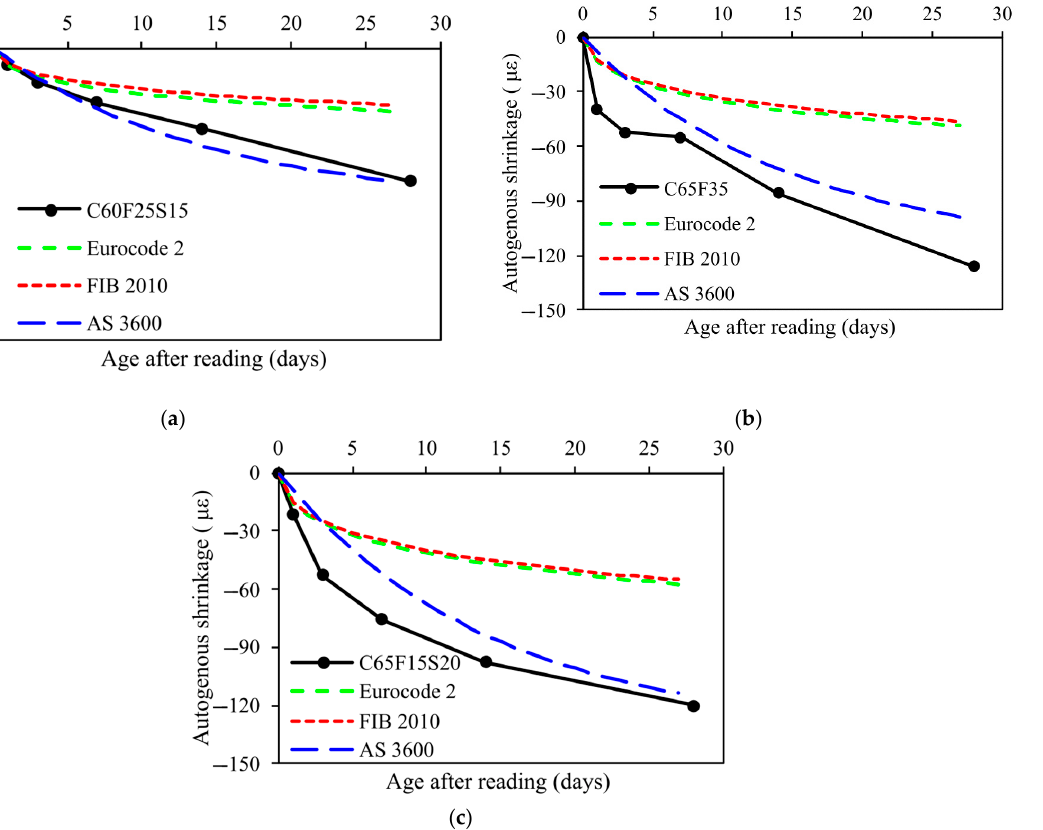
Figure 11. Comparison of the autogenous shrinkage development between experimental results and model predictions: ( a ) C60F25S15; ( b ) C65F35; ( c ) C65F15S20. model predictions: ( a ) C60F25S15; ( b ) C65F35; ( c )